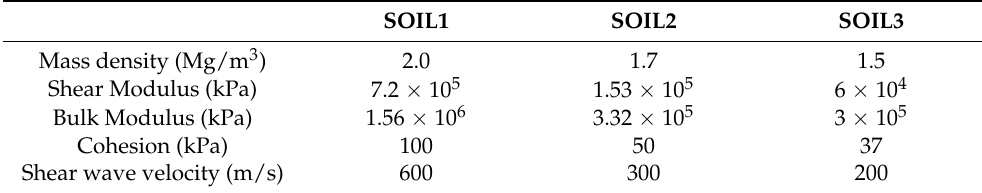
Figure 3. Backbone curves. Table 2. Soil parameters.